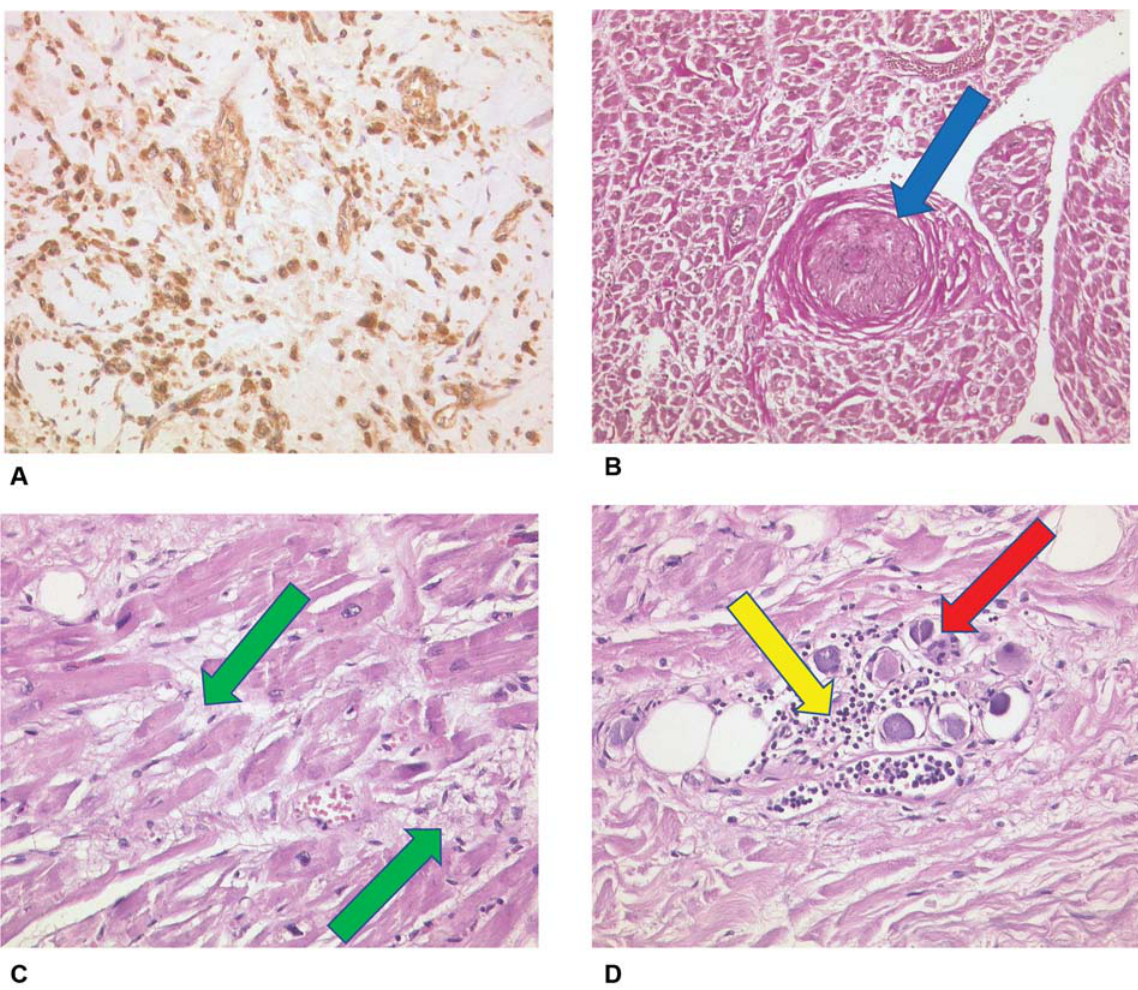
Fig.6 ( A ) Thrombus in organization with IL-6-expression (brown colored stain) of endothelial cells, Fibroblasts and macrophages (IL-6, Zytomed, (cid:1) 40 magni fi cation). ( B ) Right atrium, stenosing microangiopathy “ small vessel disease ” (blue arrow), Elastika-van-Gieson (EvG), (cid:1) 20 magni fi cation. ( C ) Right atrium, fresh myocardial necroses (green arrows), H&E, (cid:1) 40 magni fi cation. ( D ) Right atrium, nerval ganglion cells with lymphocyte in fi ltration (yellow arrow) and viral alterations (red arrow), H&E, (cid:1) 40 magni fi cation. H&E, hematoxylin and eosin; IL,